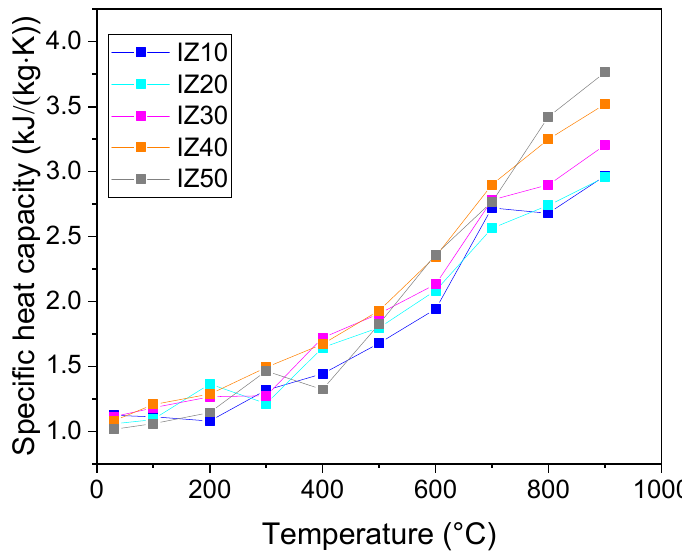
Figure 11. Specific heat capacity of the samples.